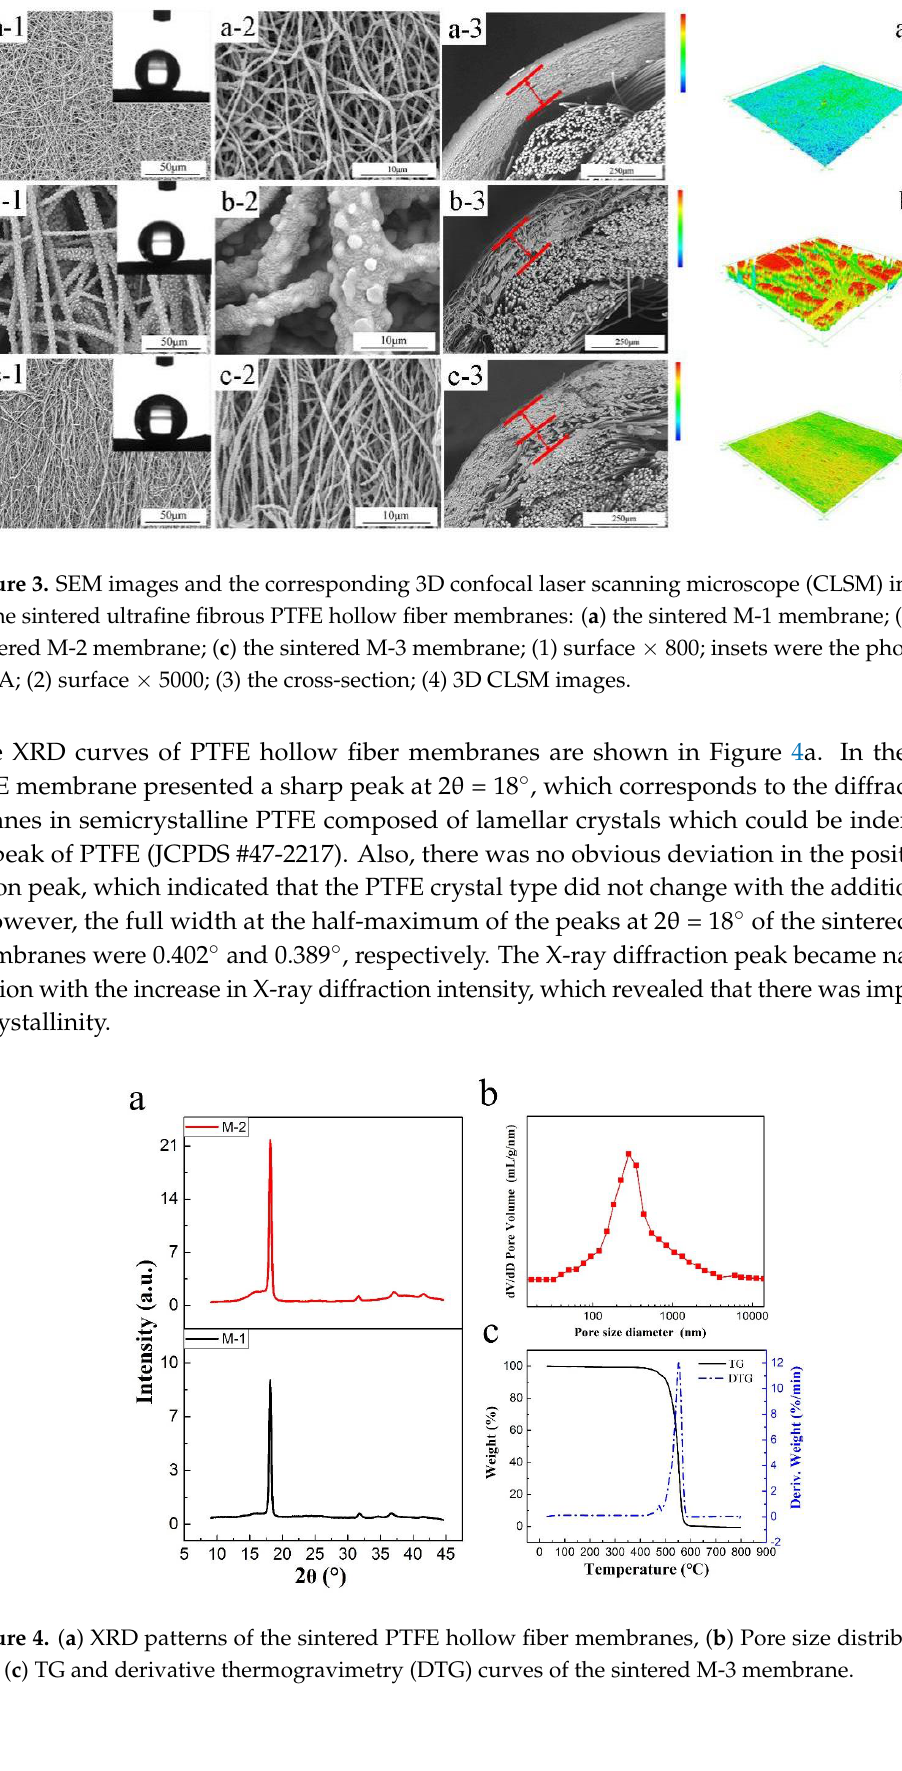
Figure 4. ( a ) XRD patterns of the sintered PTFE hollow fiber membranes, ( b ) Pore size distribution, and ( c ) TG and derivative thermogravimetry (DTG) curves of the sintered M-3 membrane.